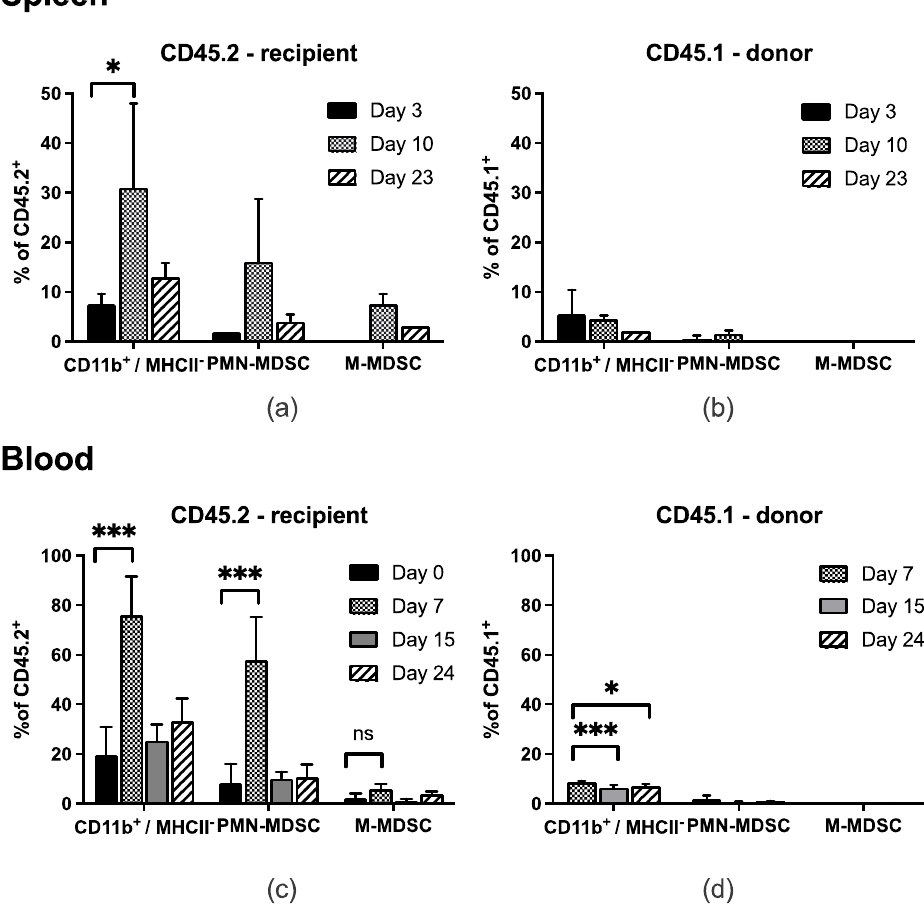
Figure 1. Myeloid cells from spleen and blood at different time points after LRAST-treatment . C57BL/6 mice were exposed to 5 × 10 4 D5-cells by s.c. injection and treated according to the LRAST scheme with cyclophosphamide (L) and active-specific vaccination (AST). CD11b + MHC-II − cells, PMN-MDSC (CD11b + Ly6G + Ly6C + ) and M-MDSC (CD11b + Ly6G − Ly6C high ) from spleen ( a , b , n = 2) and blood ( c , d , n = 3) were determined on days 3, 10 and 23 (spleen) and 0, 7, 15 and 24 (blood, except for CD45.1 + donor cells, which were not in situ of the recipient mice on day 0). Frequencies of the different myeloid cell types are depicted as percentages of CD45 + leucocytes and separated into CD45.2 + (recipient mouse, a , c ) and CD45.1 + (donor mouse, b , d ) cells, respectively. Data are means with SD, and two-way ANOVA was performed. Symbols indicate: * p < 0.05; *** p <